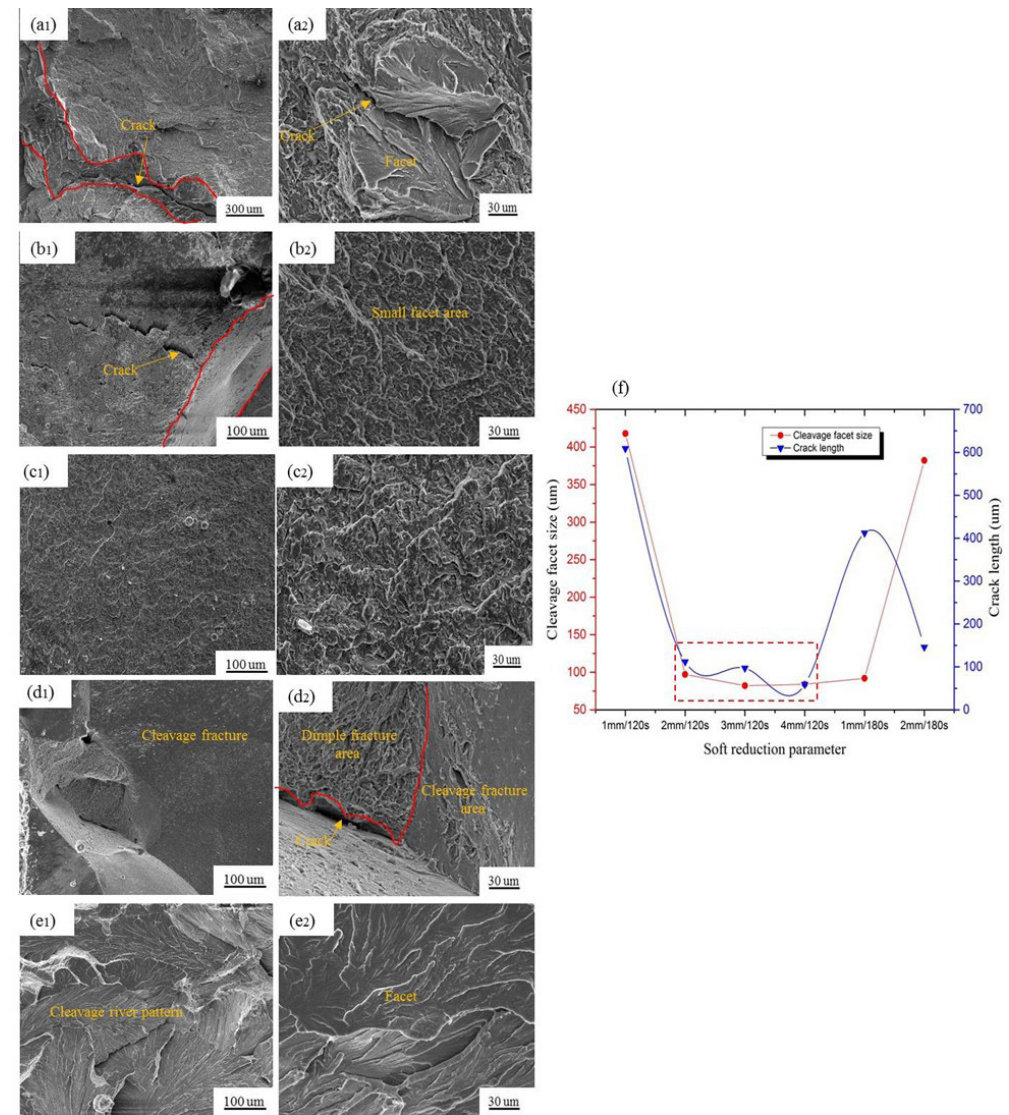
Figure 12. SEM fractographs, (a1, a2) 1mm/180s, (b1, b2) 2mm/180s, (c1, c2) 3mm/180s, (d1, d2) 4mm/180s and, (f) The relationship between cleavage facet size and crack length at cooling time of 120s and 180s with different reduction amounts.